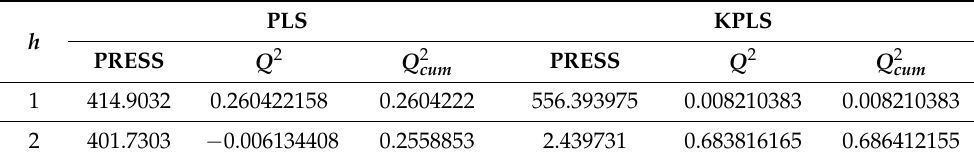
Table 5. Results of predictive ability of PLS and